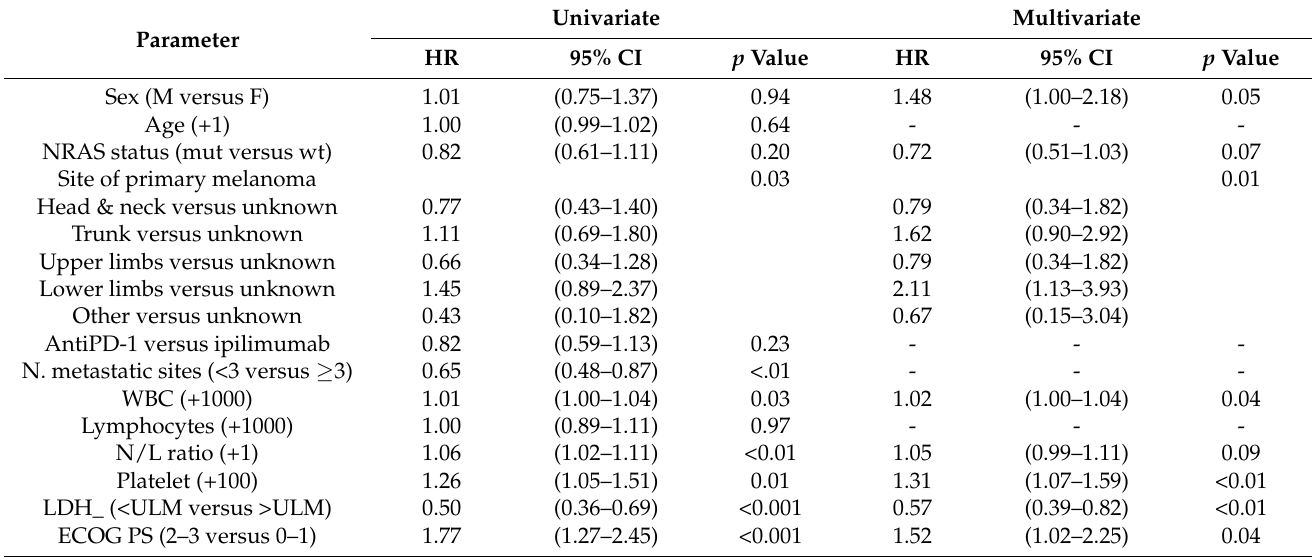
Table 8. Univariate and multivariate analysis of overall